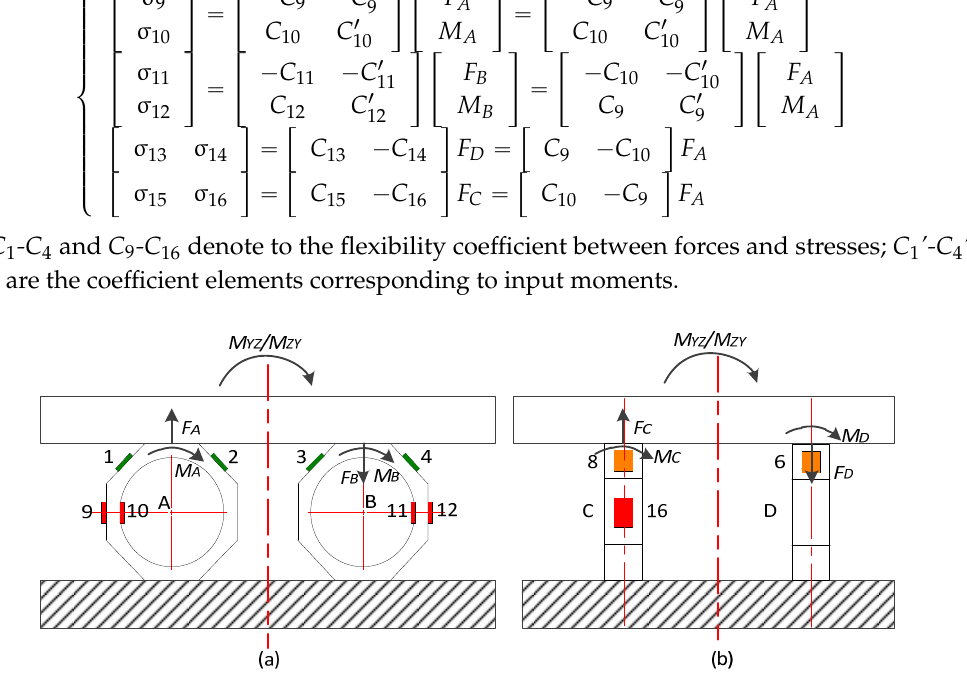
Figure A2. ( a ) Ring A and B under X axial moment; ( b ) Ring C and D under X axial moment.